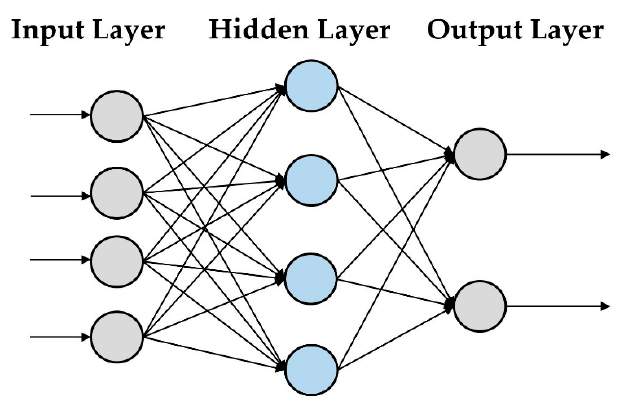
Figure 1. Structure of a three-layer feedforward neural network.